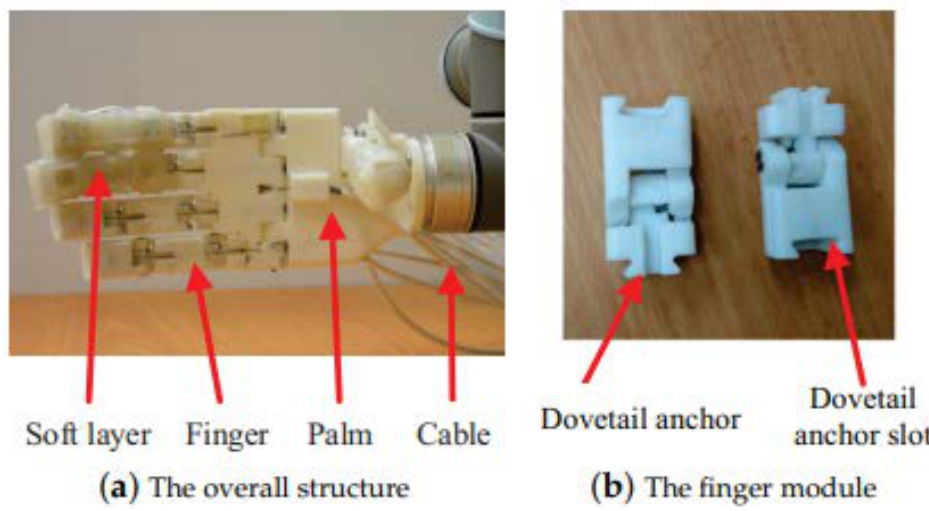
Figure 4. ( a ) shows the composition of the hand assembly, which is comprised of a soft layer for the index, thumb, and middle finger. ( b ) shows the way that the interconnected joints of the finger assembly connect to one another with dovetail anchor plugs and sockets (Reprinted with permis- sion from Zhu, G. et al. [36]. Copyright 2020, CC BY 4.0